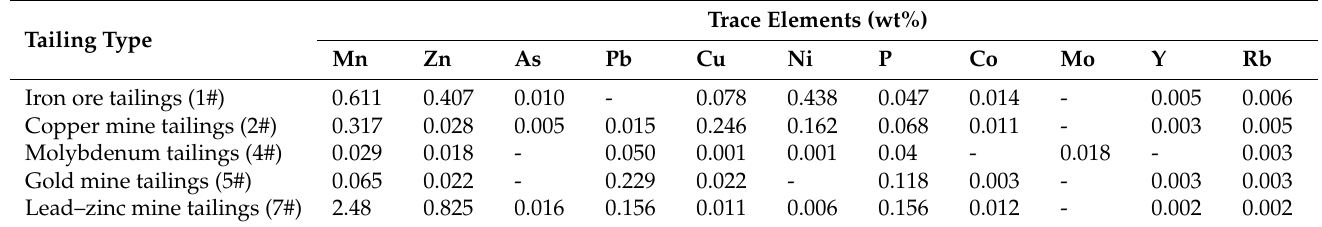
Table 5. Characteristics of trace elements in different tailings of typical mining areas in Tibet Au- tonomous Region.